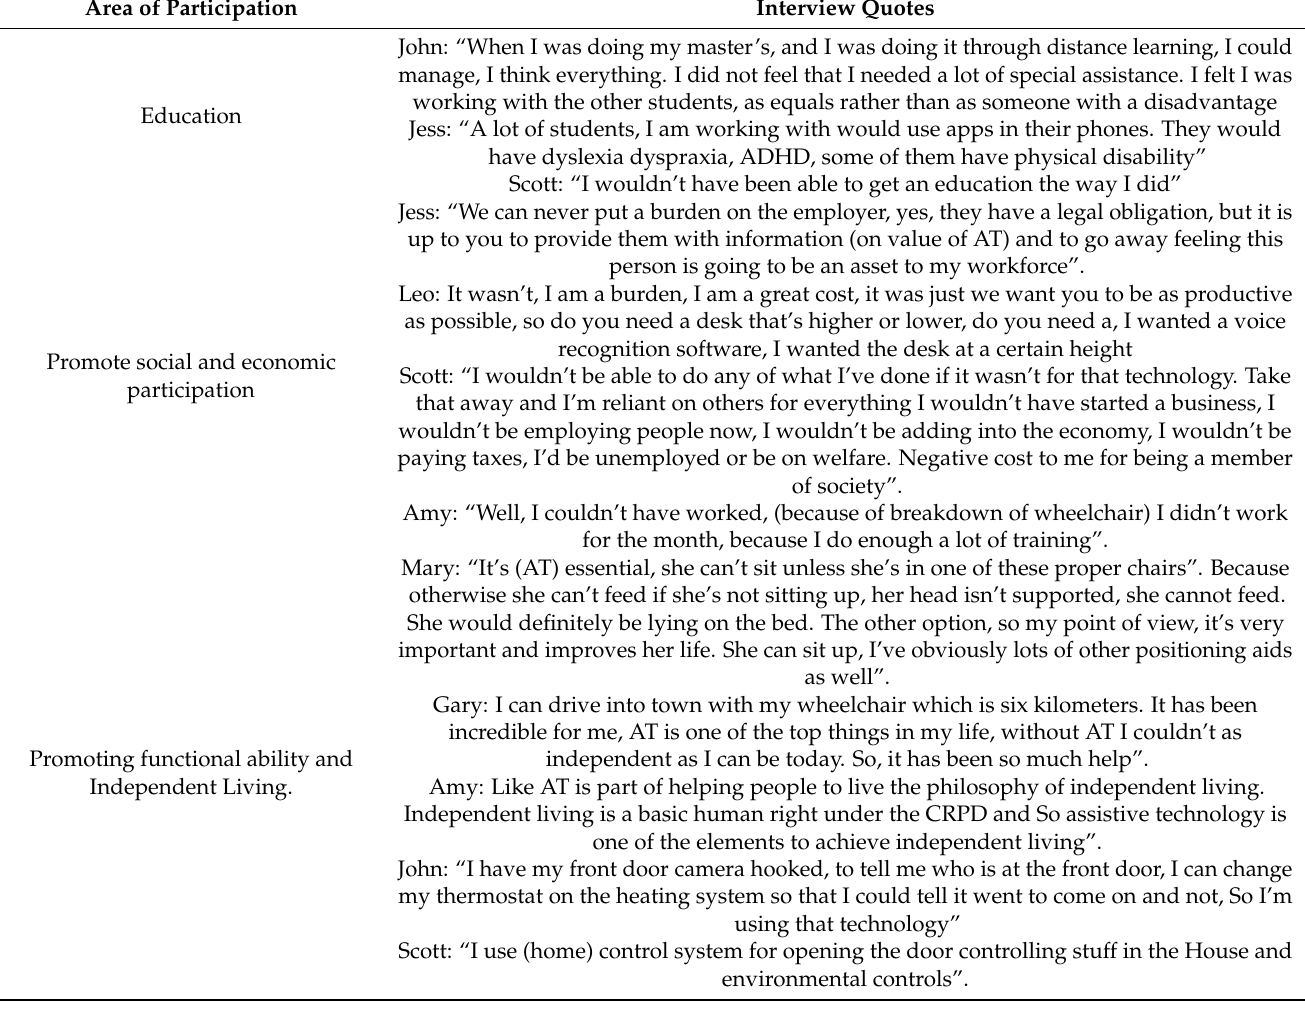
Table 3. Value of AT in promoting equal participation in different facets of